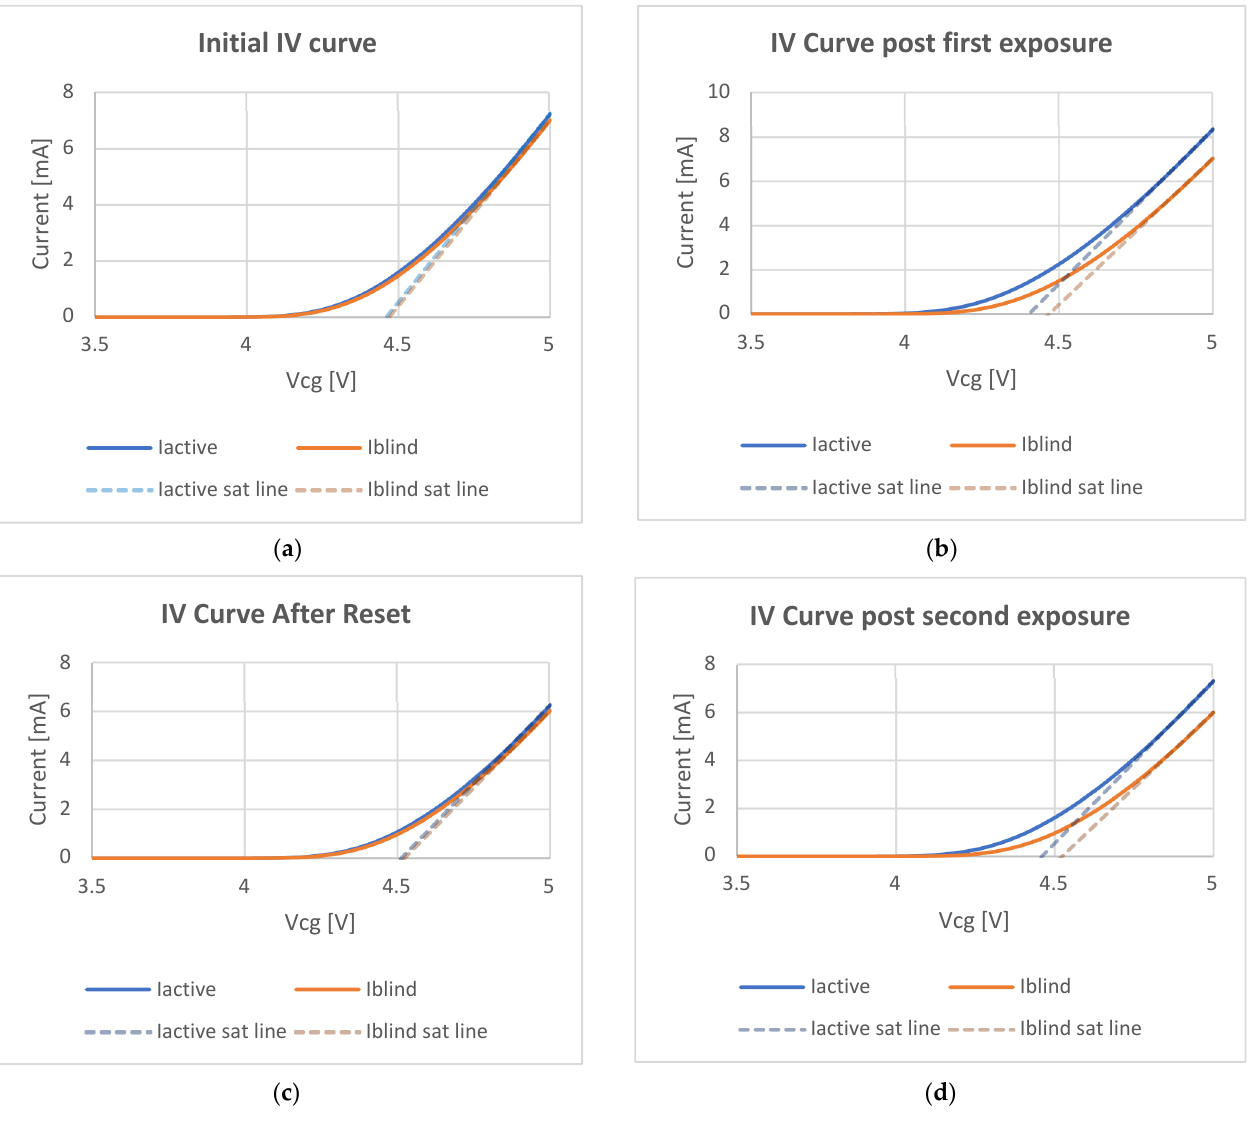
Figure 8. Blind and Active arrays IV curve. ( a ) Initial IV curve. ( b ) post 6 min exposure IV curve. ( c ) IV curve after reset. ( d ) post second 6 min exposure. Table 1. Summary of CMOS Sensor exposure to Alpha